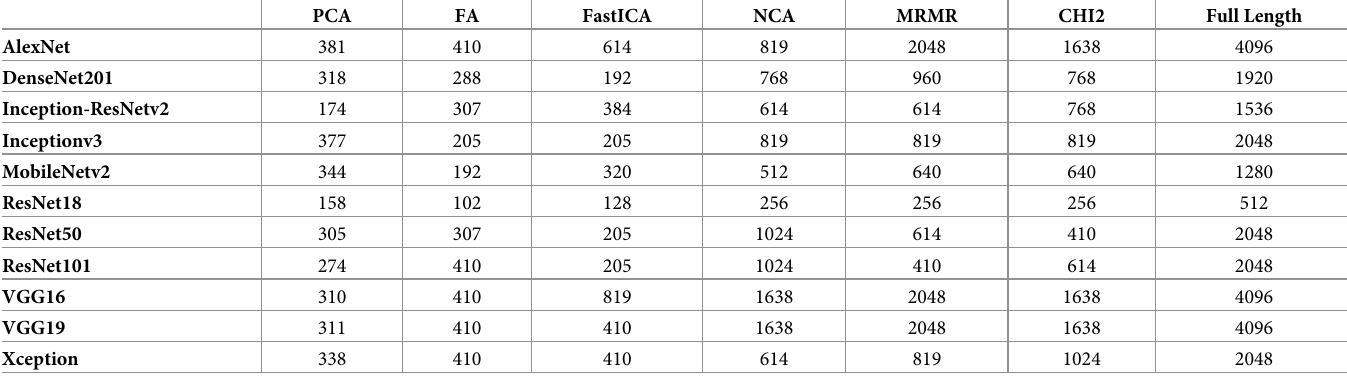
Table 6. The feature length of each DCNN model and DR/FS method combination.